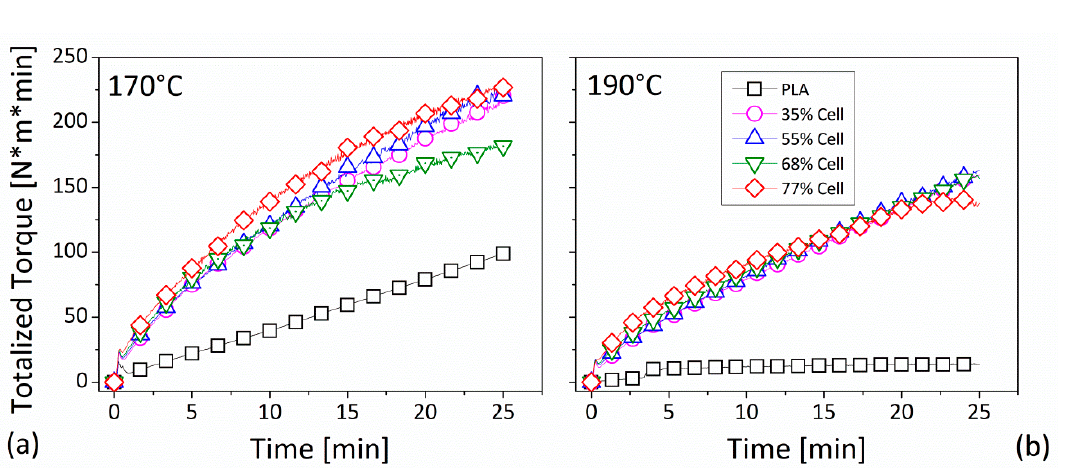
Figure 4. Totalized torque as a function of the mixing time for all of the investigated formulations: ( a ) ( a ) at 170 ◦ C, ( b ) at 190 ◦ C. Legend in Figure 4b as in Figure at 170 °C, ( b ) at 190 °C. Legend in Figure 4b as in Figure 4a.